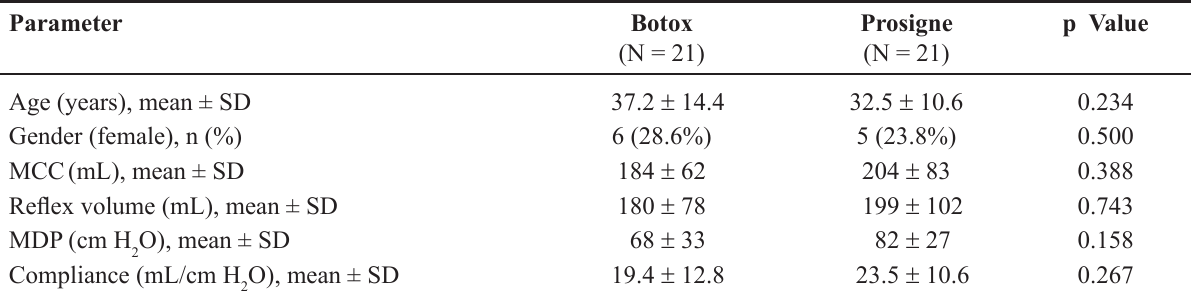
Table 1 – Baseline characteristics of evaluable patients treated with Botox or Prosigne.